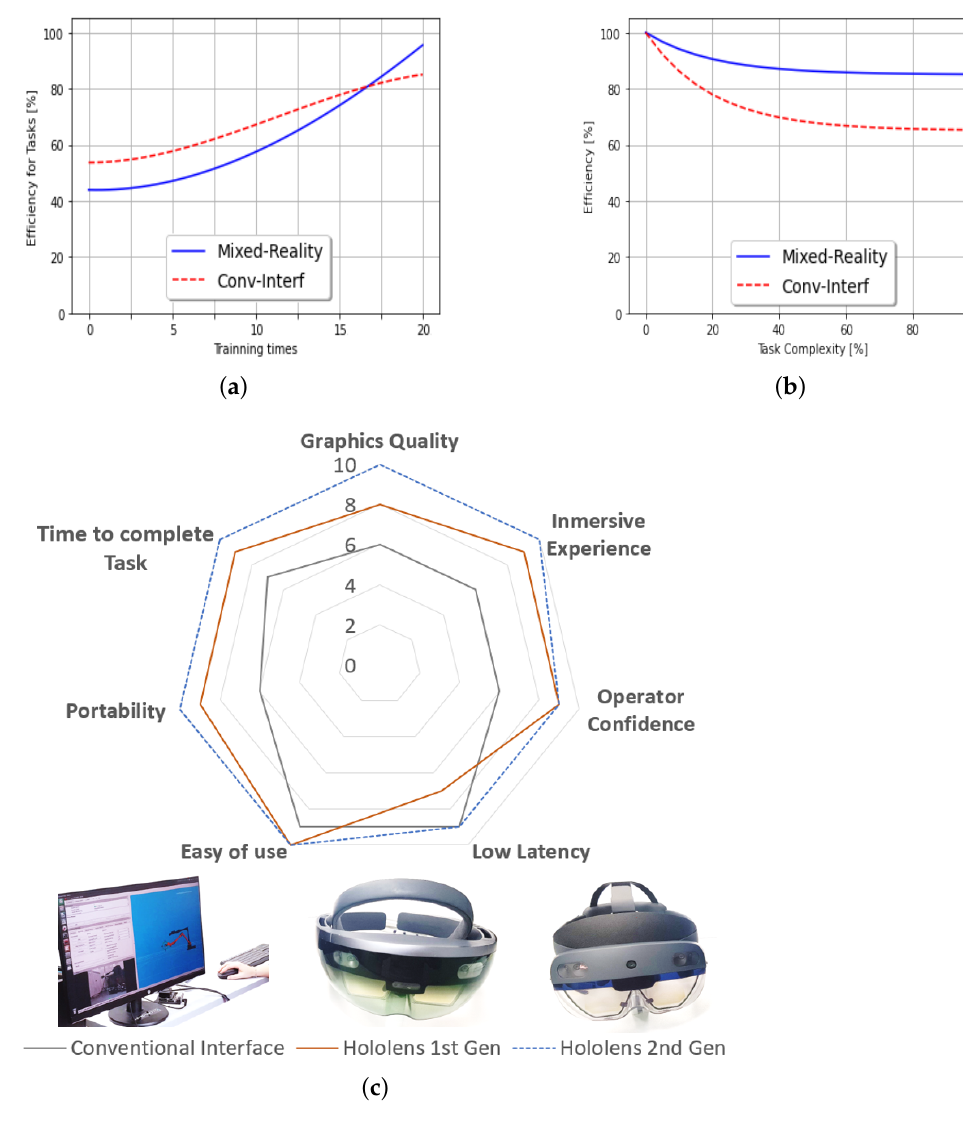
Figure 8. Evaluation metrics to analyze the performance of conventional and MR interfaces. ( a ) Ef- ficiency based on training analysis. ( b ) Task complexly evaluation. ( c ) Parametric comparison of the technological elements for tele-operation the robotic set through conventional interface (screen, mouse, keyboard) and MR interface (Hololens 1st and 2nd